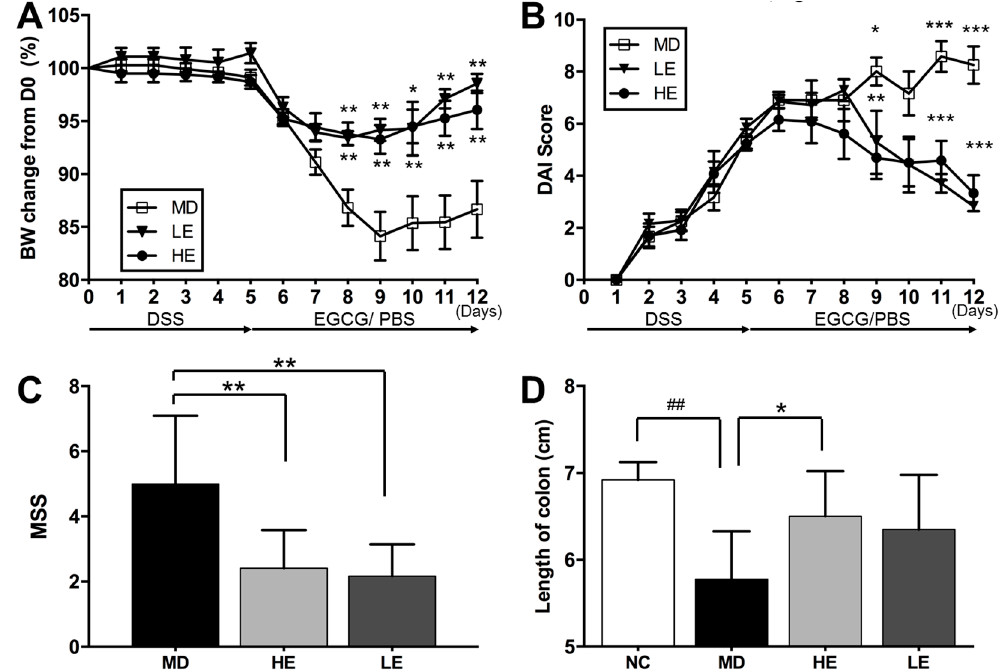
Figure 2. Effect of EGCG treatment on body weight, disease activity index (DAI) score, macroscopic severity score, and colon length following DSS-induced colitis. Both high and low doses of EGCG treatment significantly improved DSS-induced ( A ) body weight loss, ( B ) DAI score, ( C ) macroscopic severity score (MSS). High-dose EGCG markedly restored ( D ) colon length. Body weight changes were measured daily and calculated as the percentage change from Day 0. DAI scores were assessed from Day 1 to Day 12. MSS and colon length were evaluated at the end of the study. BW: Body weight, DAI: Disease activity index, DSS: Dextran sulfate sodium, EGCG: Epigallocatechin gallate, MSS: Macroscopic severity score, PBS: Phosphate bu ff ered saline; NC: Normal control group, MD: Colitis model group, HE: High-dose EGCG group, LE: Low-dose EGCG group. Data are presented as mean ±